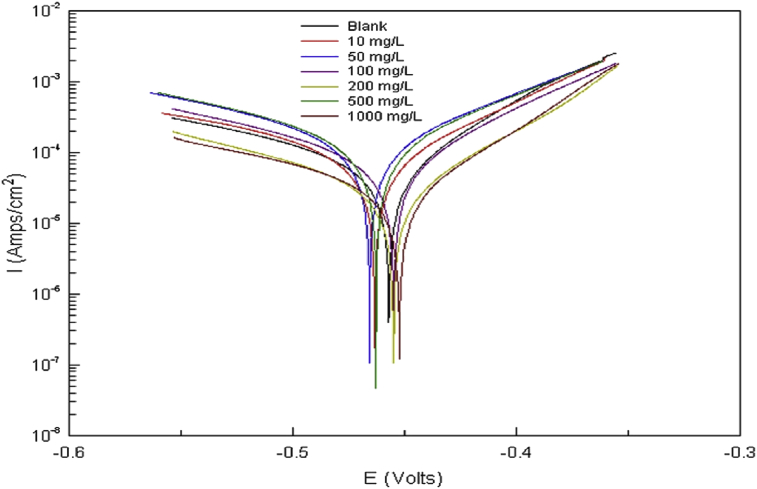
Polarization curves for Q235A steel corrosion in 1M HCl in the absence and presence of varying concentrations of persimmon husk extracts as OGCI [59].